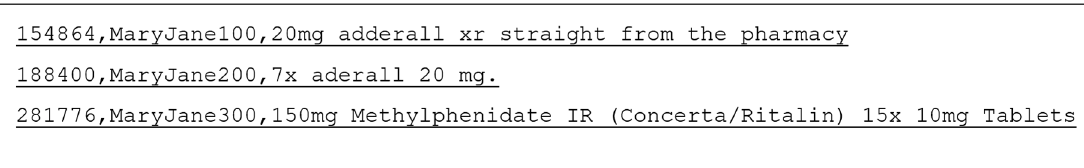
Figure 4. Structure of Listing Data from Marketplace.